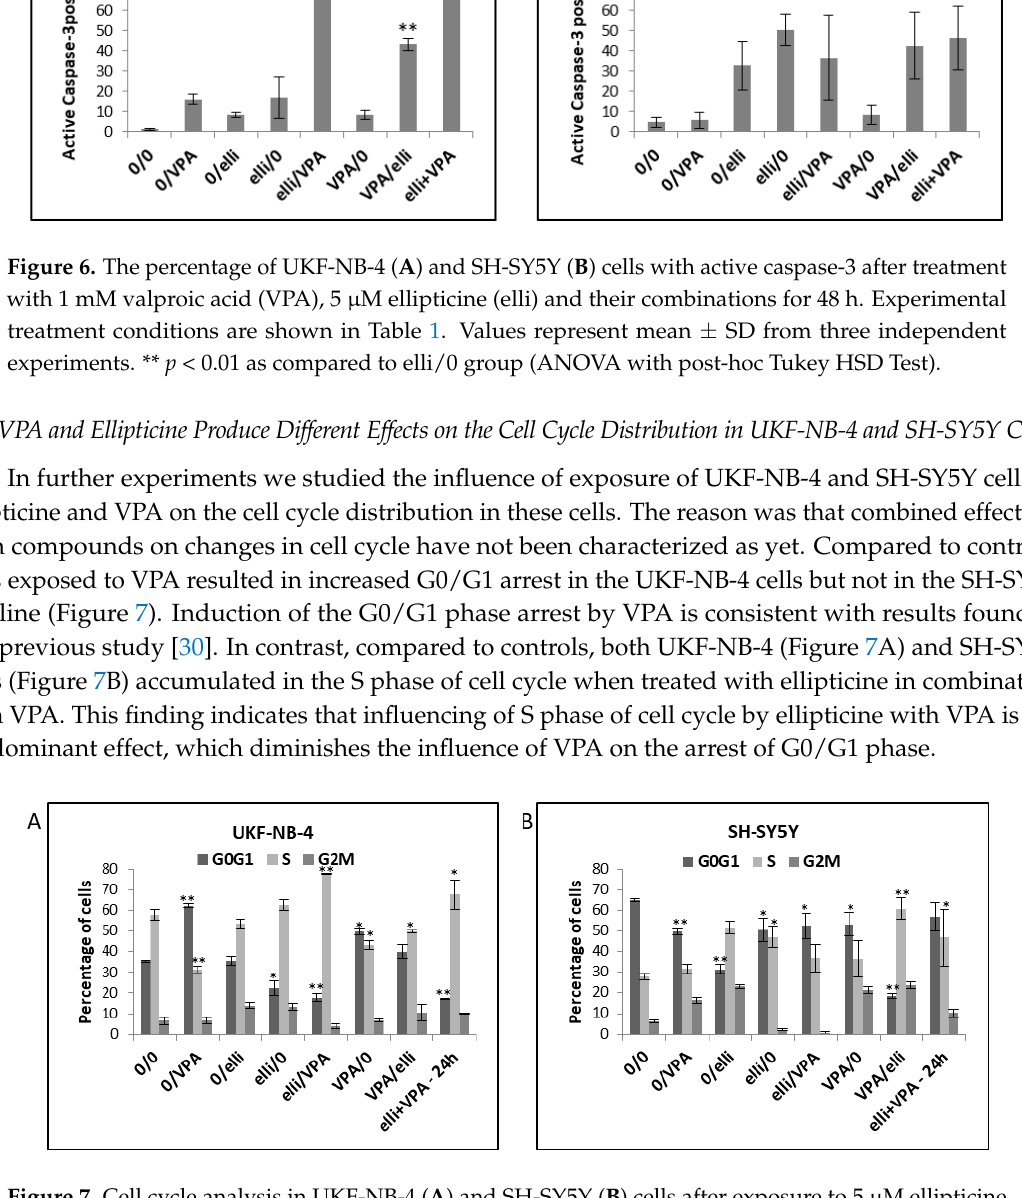
Figure 7. Cell cycle analysis in UKF-NB-4 ( A ) and SH-SY5Y ( B ) cells after exposure to 5 µM ellipticine (elli) and 1 mM valproic acid (VPA) and their various combinations. Experimental treatment conditions are shown in Table I. Values represent mean ± SD from three independent experiments. ** p < 0.01, * p < 0.05 as compared to 0/0 group (ANOVA with post-hoc Tukey HSD Test).